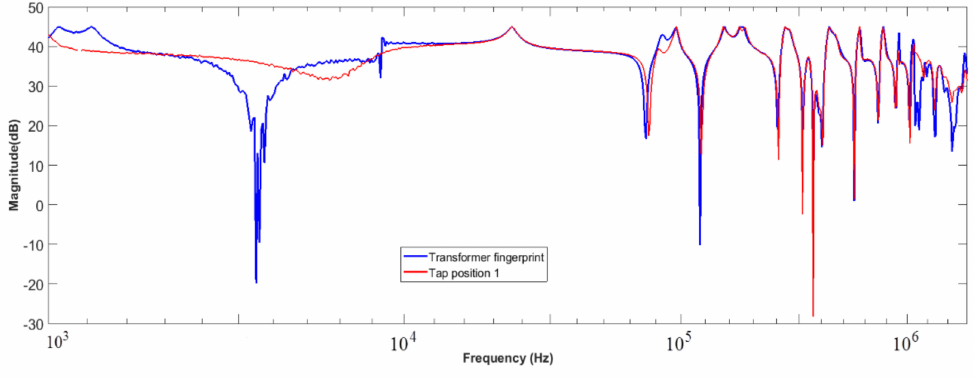
Figure 13. Comparison between fingerprint and regulator winding (Phase C).